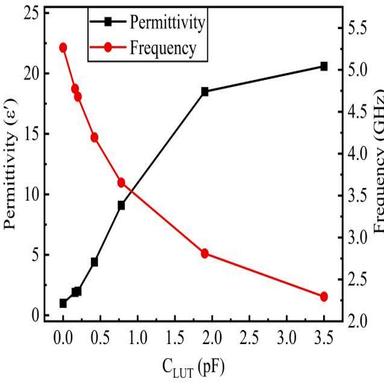
Real part of permittivity (ε′ r) and Frequency as a function of CLUT.